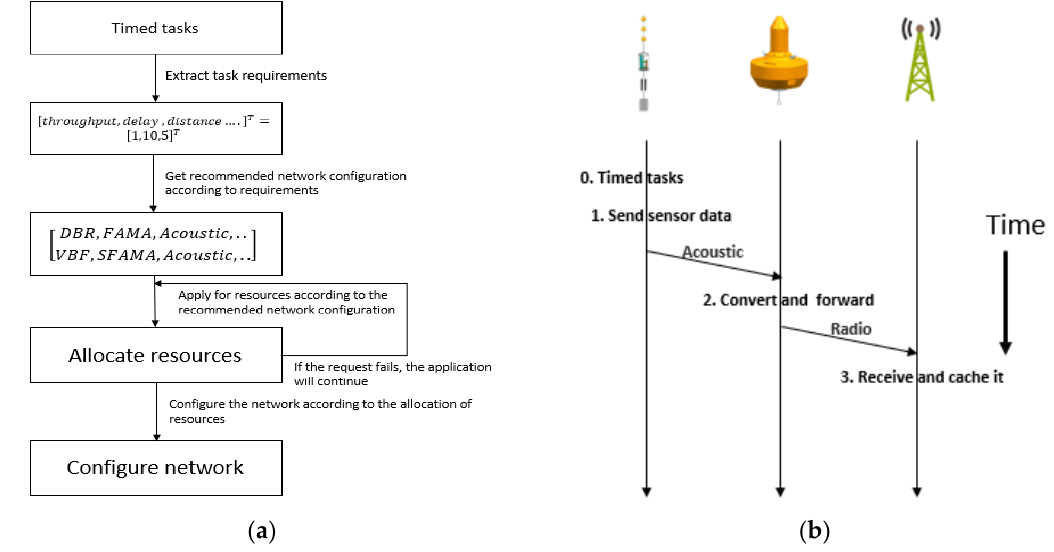
Figure 14. ( a ) Application process of network resources for timed tasks; ( b ) detailed information of interaction between timed task terminals in underwater environment monitoring network.